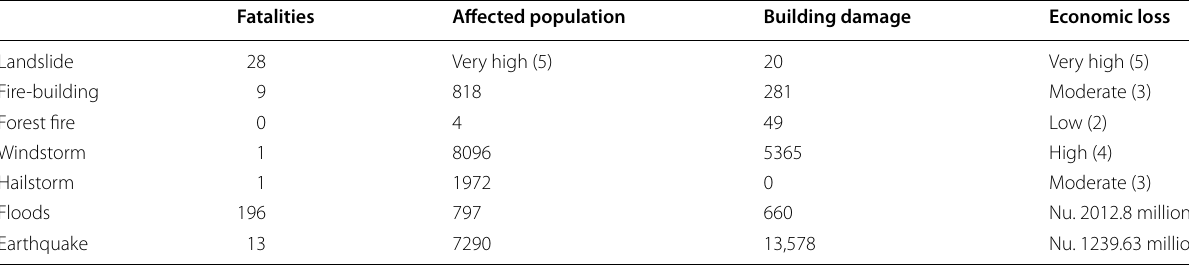
Table 5 Summary of reported cumulative hazard